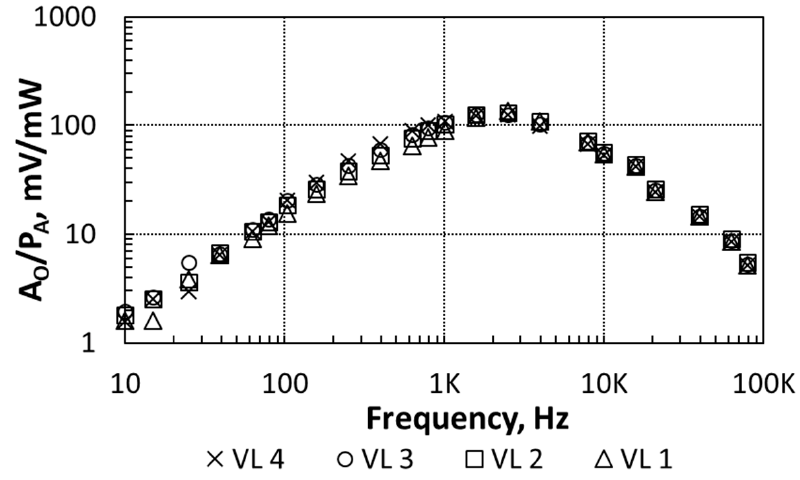
Figure 9. Sensor’s sensitivity as a function of the frequency. See Table 2 for the VL description and the PA values. Measurements taken with the LIA.